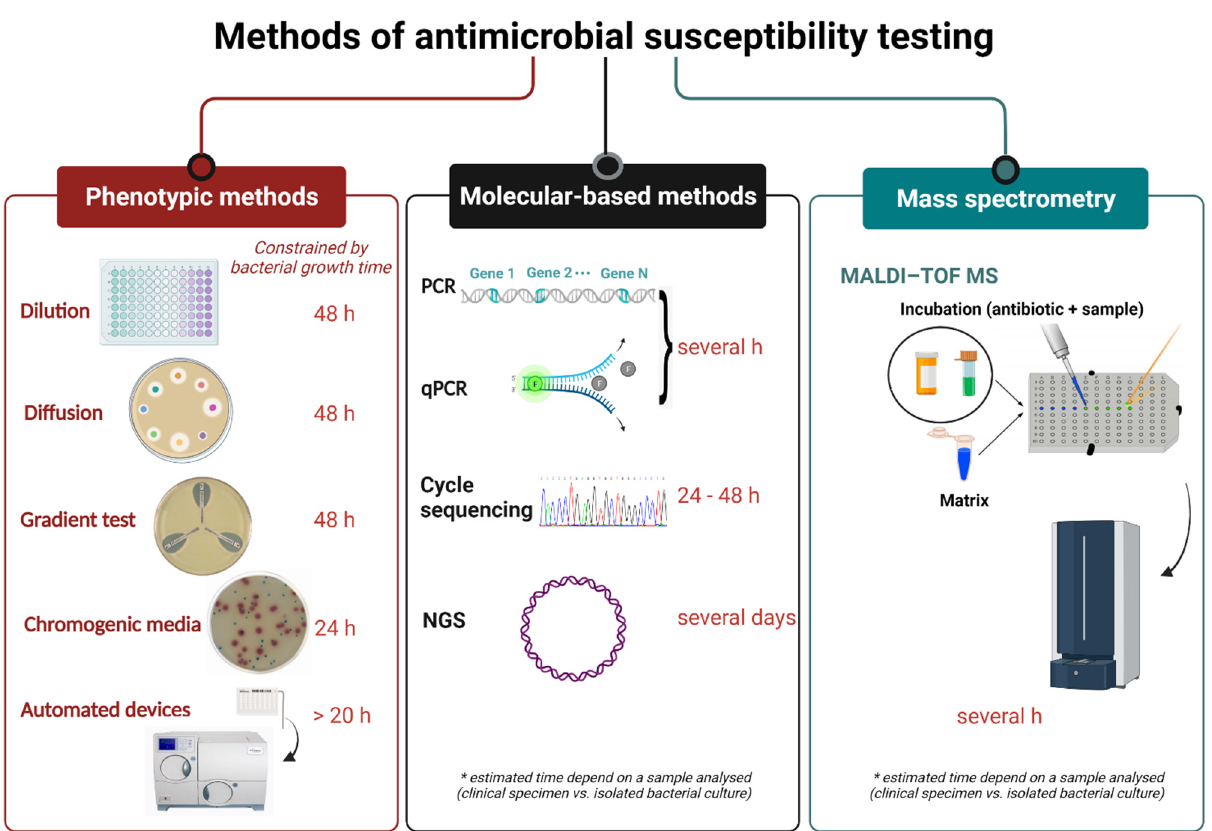
Figure 1. Current methods for antimicrobial susceptibility testing and turnaround time (created with BioRender.com, accessed on 27 February 2022. Reproduction of this figure requires permission from BioRender.com). PCR—polymerase chain reaction. qPCR—quantitative polymerase chain reaction. NGS—next-generation sequencing. MALDI-TOF MS—matrix-assisted laser desorption/ionization time-of-flight mass spectrometry.